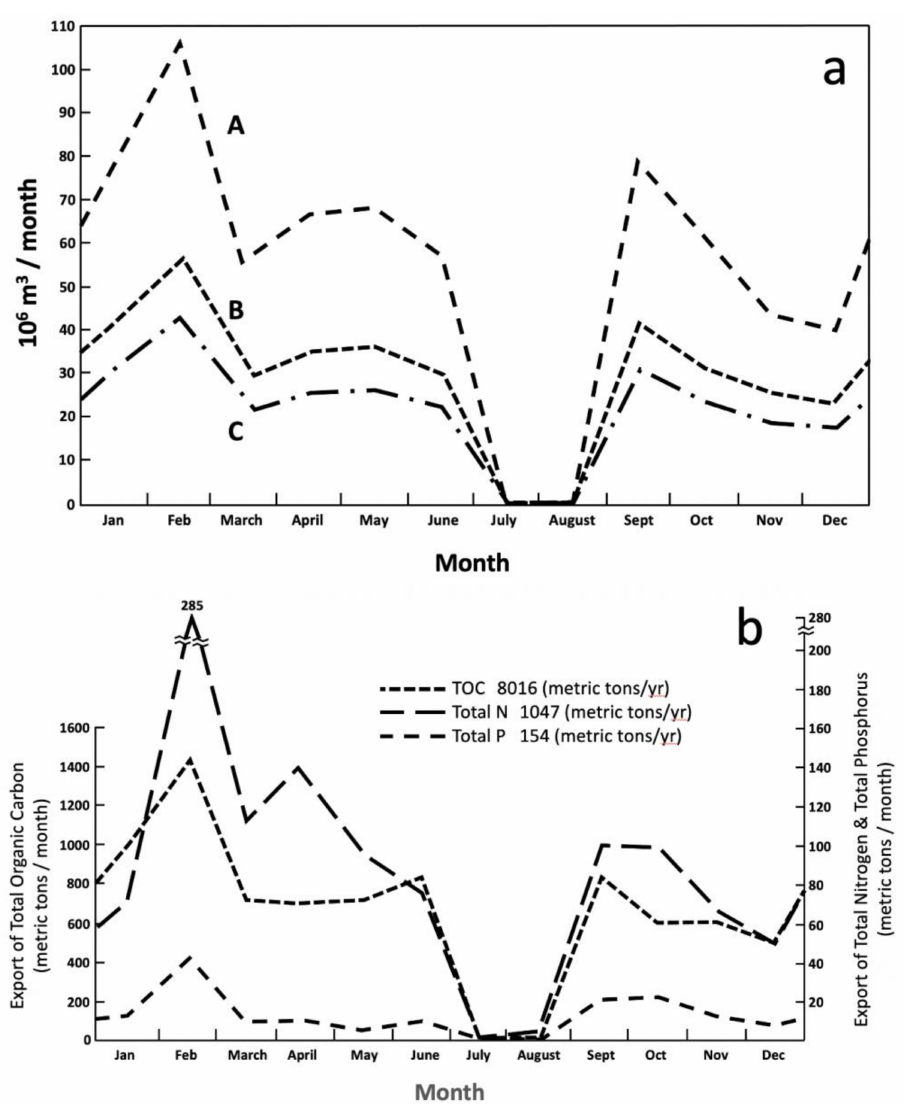
Figure 5. ( a ) Water flowing into and out of Lac des Allemands. Monthly mean water discharge at bayous des Allemands (A), Boeuf (B), and Chevreuil (C). Bayous Boeuf and Chevreuil account for most water flowing into Lake des Allemands, and Bayou des Allemands is the single outlet from the upper basin to the lower basin. Water discharge was zero in July and August because evapo- transpiration exceeded precipitation (modified from [34]; data collected 1975–1976); ( b ) Materials export to the lower estuary measured at Bayou des Allemands, the only outlet from the upper basin (modified from [34]; data collected 1975–1976). The lines in the graph are monthly export values. Annual loadings for TOC, TN and TP are provided in the upper